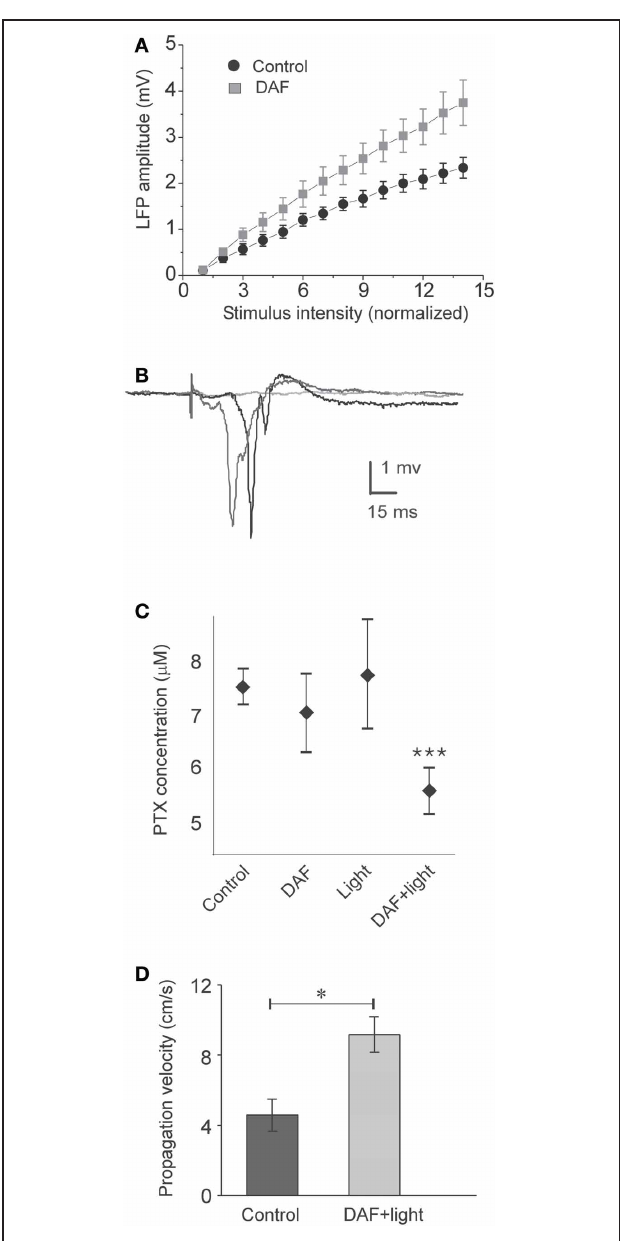
FIGURE 4 | DAF-treated slices are disinhibited. The treatment consisted of 10min incubation in a solution containing 2 μ M DAF-2DA, and 5min fluorescent illumination through the 4 × objective. (A) A plot of the average LFP amplitude against the normalized stimulus intensity demonstrates steeper slope for DAF-treated slice ( n = 9) compared with control slices ( n = 9). (B) An example of three consecutive traces of synchronized epileptic activity recorded at a single point in DAF-treated slice, when inhibition was further reduced by PTX (5 μ M), demonstrating a failure and two synchronized events of variable latency (shades of gray). (C) Threshold concentrations of PTX required for eliciting epileptic activity as in (B) , under different conditions (control – n = 9; DAF-2DA – n = 9; light – n = 10; DAF-2DA + light – n = 11). Note significantly reduced dose in slices which have been treated with DAF and illumination. (D) The propagation velocity of epileptic discharge at suprathreshold concentrations of PTX is higher in DAF-pretreated slices ( n = 12) compared with non-treated slices ( n = 13), reflecting pre-existing